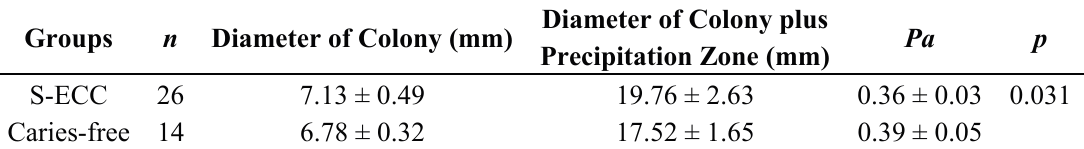
Figure 1. The comparison of Pa value and Saps activity of Candida albicans strains isolated from severe early childhood caries (S-ECC) and caries-free children. White bars and black bars represent the means (with standard deviations) of Pa values (the ratio of the diameter of the colony to the total diameter of the colony plus the zone of precipitation), which represents Saps activity of C. albicans from S-ECC and caries free (CF) children. * denotes statistical significance ( p <